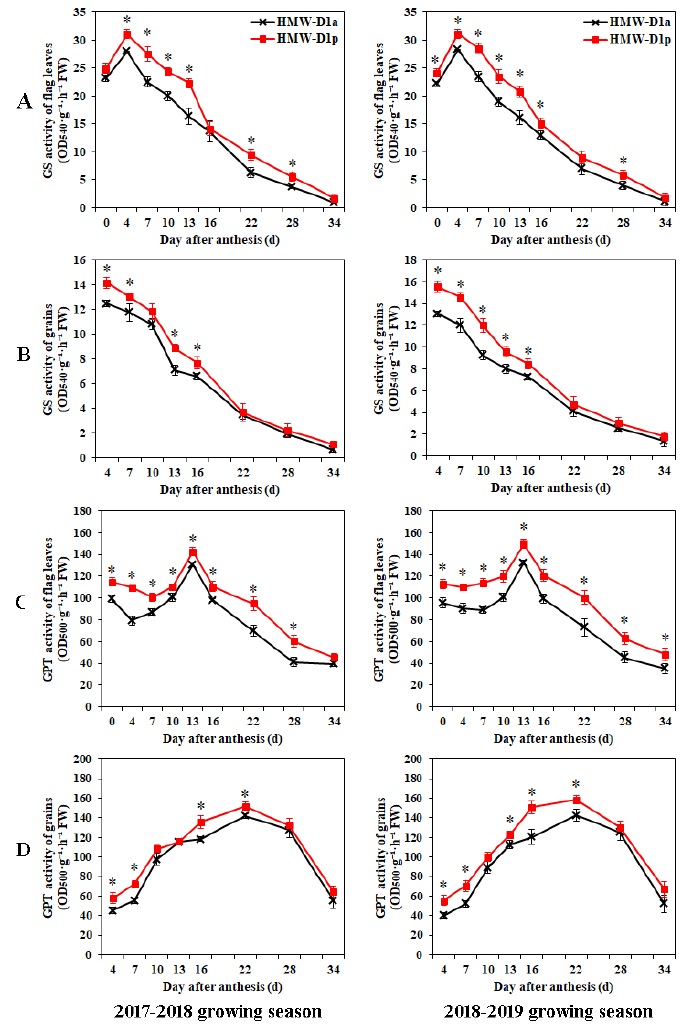
Figure 4. Changes in the GS and GPT in leaves ( A , C ) and grains ( B , D ) from HMW ‐ D1a and HMW ‐ D1p over two growing seasons, 2017 ‒ 2018 (left) and 2018 ‒ 2019 (right). GS, glutamine synthetase; GPT, glutamate pyruvate transaminase; FW, fresh weight. Red and black lines represent the HMW ‐ D1p and HMW ‐ D1a, respectively. * indicates significant difference at same developing stage of the two materials ( p < 0.05).